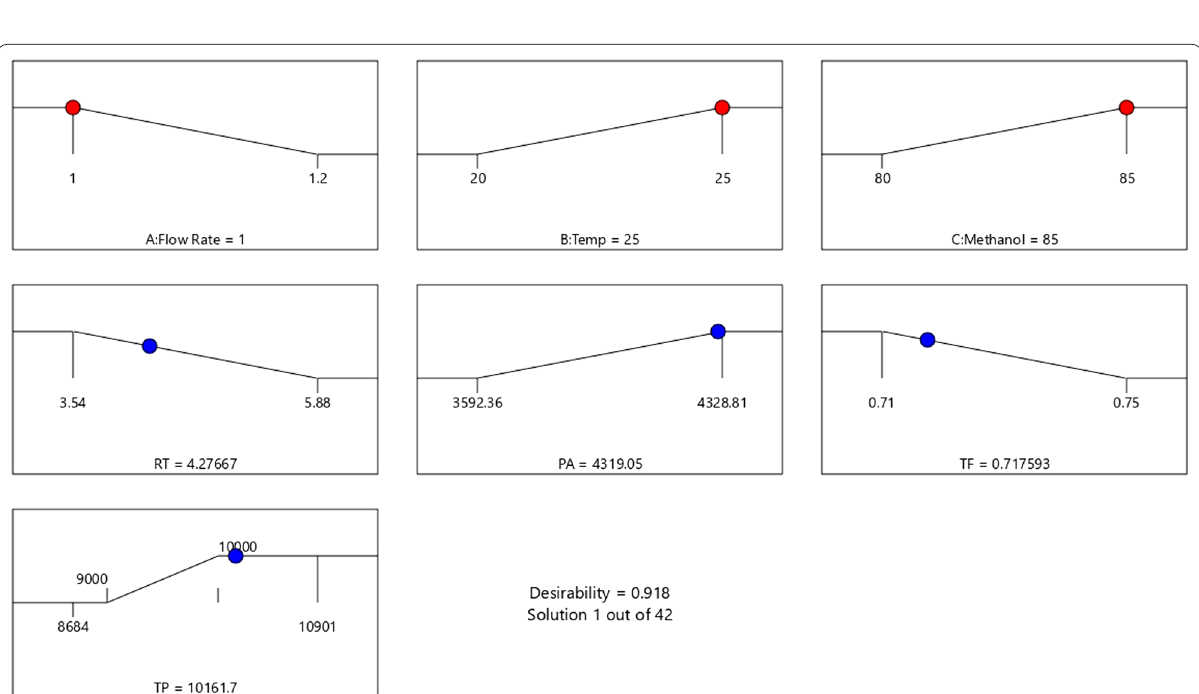
Fig. 12 Numerical optimization graphs showing most suitable